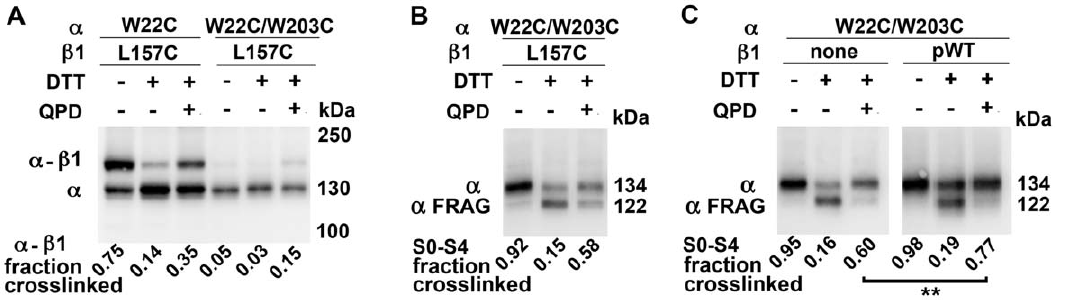
Figure 6. Competition between W203C in S4 and L157C in TM2 for crosslinking to W22C in S0. (A) Cells were transfected with indicated a and b 1 subunit mutants. In A, the extent of formation of disulfide-crosslinked a and b 1 was determined. In B and C, the extent of formation of an intra- a -subunit disulfide between S0 and S4 was determined. In all cases, three conditions as described in Fig. 4 were analyzed: untreated, reduced with DTT, and reduced with DTT and reoxidized with QPD. Mean + s.e.m. N=3. **P=0.01, paired Student’s t test.